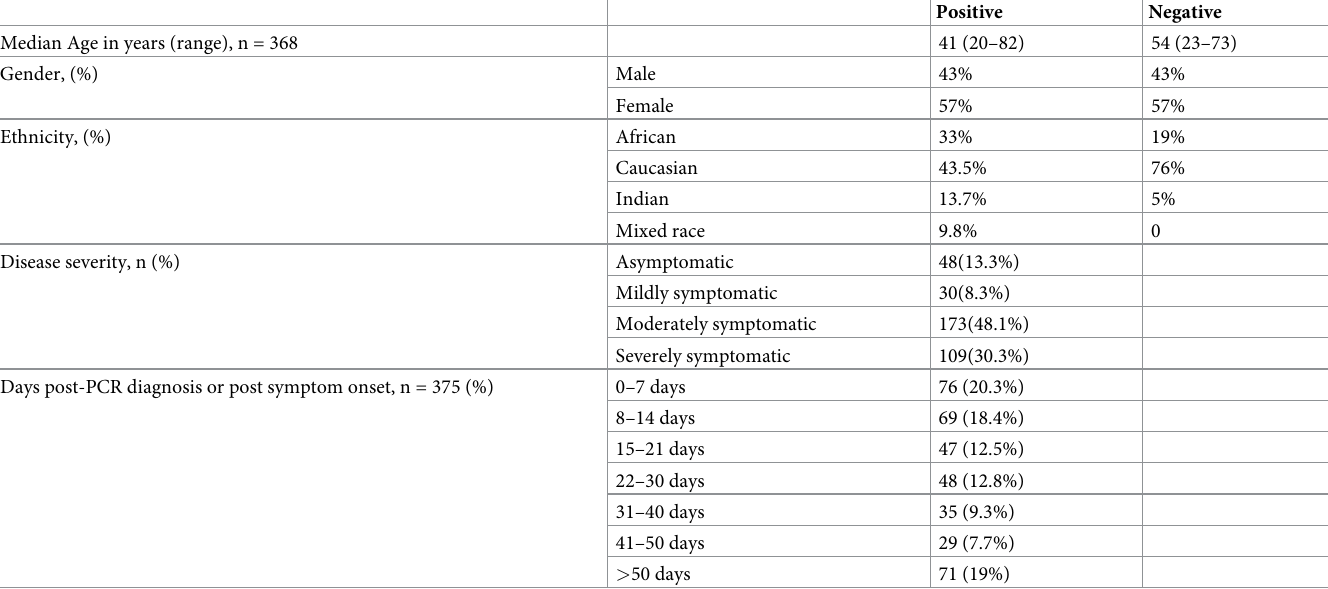
Table 1. Baseline characteristics of the study participants.